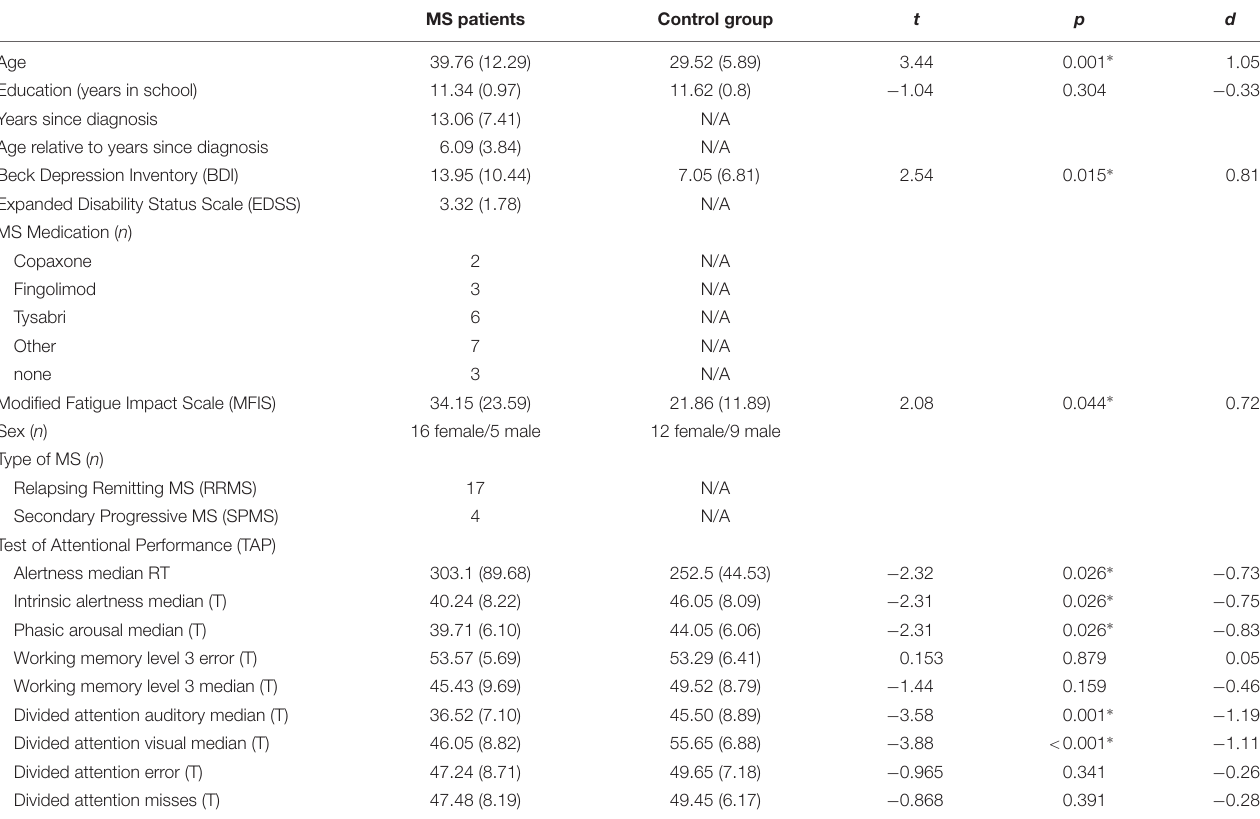
TABLE 1 | Results of neuropsychological testing and demographical data of the MS patient group and the healthy control group. MS